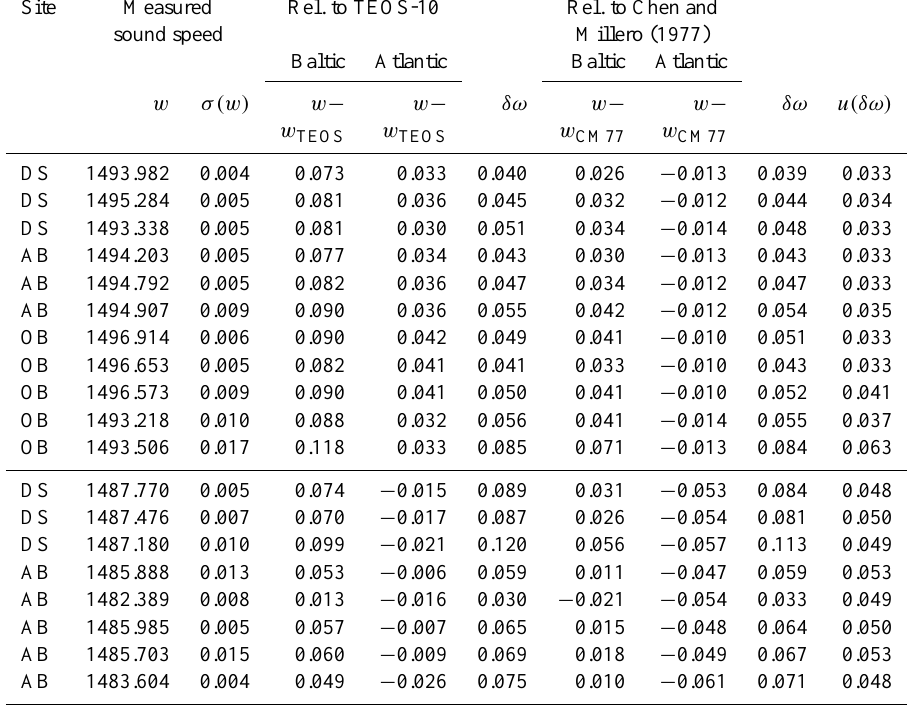
Table 4. Speed of sound measured with the time-of-flight sensor in the Baltic Sea (in ms − 1 ) ; w differences (measured minus calculated) using TEOS-10 and Chen and Millero (1977) for the Baltic in situ measurements, and for the laboratory measurements in samples of natural Atlantic seawater with S P = 7.765 (upper part of table) and S P = 16.66 (lower part). The differences in the Atlantic samples were previously interpolated to the Baltic in situ temperatures. δw are the respective estimates of the sound speed anomaly according to Eq. (2). The uncertainty estimate u(δw) (right column) is virtually the same for both reference equations. The data are in the same order as in Table